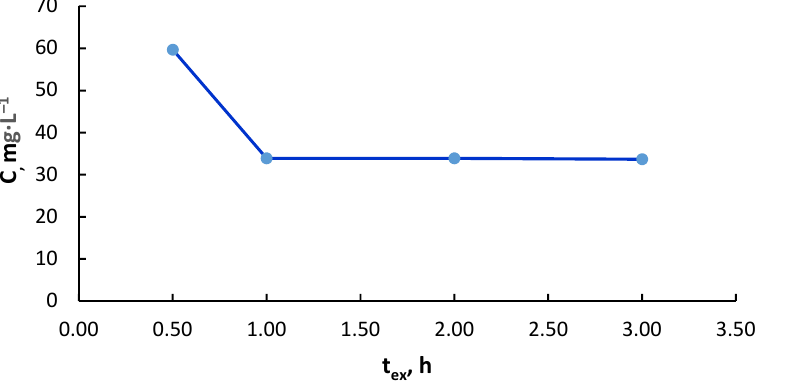
Figure 15. Change of free chlorine concentration in electrolyte solution on the experiment duration. Experimental conditions: С HCl = 6 M, i = 0.88 A·cm –2 .